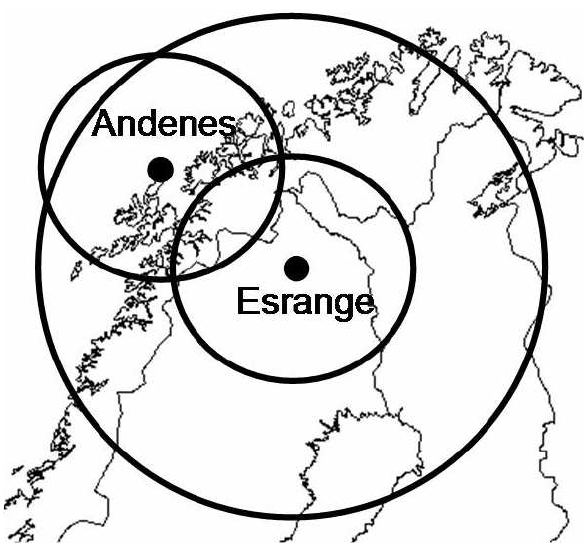
Fig. 1. Map showing northern Scandinavia and the two observation sites (black dots). The nominal circular field of view ( ∼ 600 km at 90 km altitude) of the airglow imager is also marked. The two smaller circles show theregionswherethemajority ofmeteorechoesaredetected bythetwometeor radars(diameterof ∼ 400km).